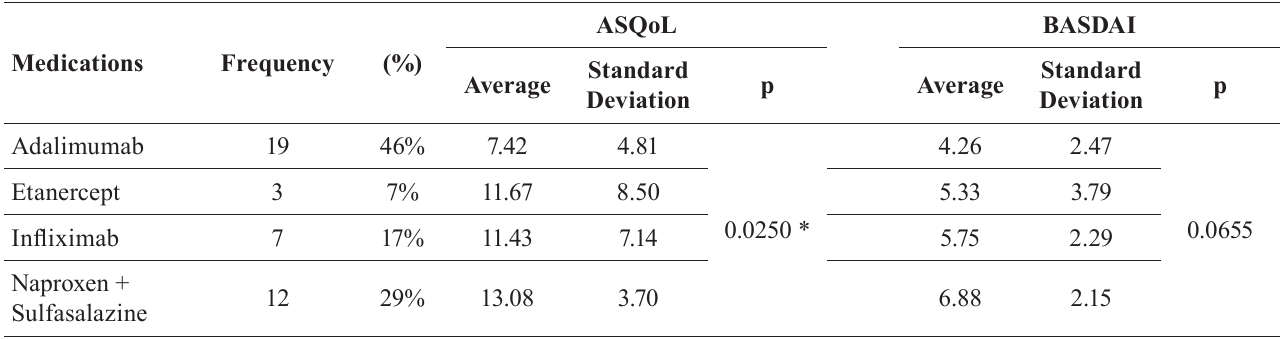
TABLE III – Frequency distribution and analysis of variance for the ASQoL and BASDAI indexes, according to pharmacological